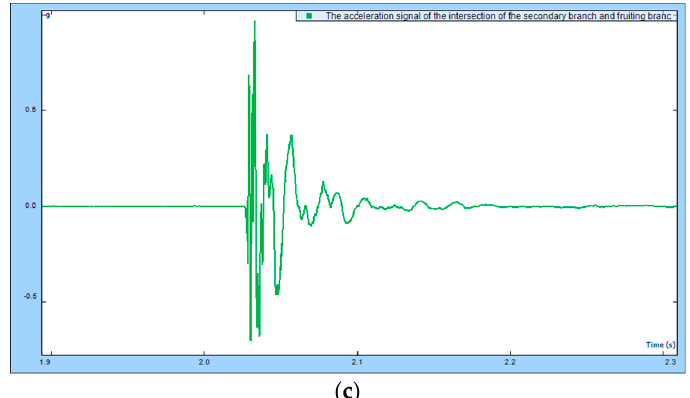
Figure A2. The acceleration signals of the intersection of the main branch and primary branch ( a ), the intersection of the primary branch and secondary branch ( b ), and the intersection of the secondary branch and fruiting branch ( c ).